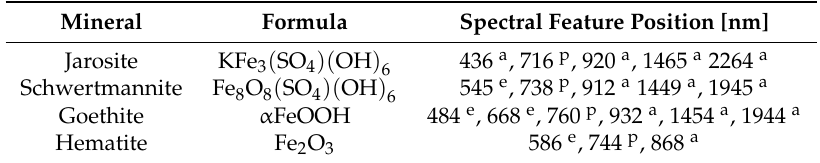
a Indicated absorption maximum; p Indicated absorption peak; e Indicated absorption